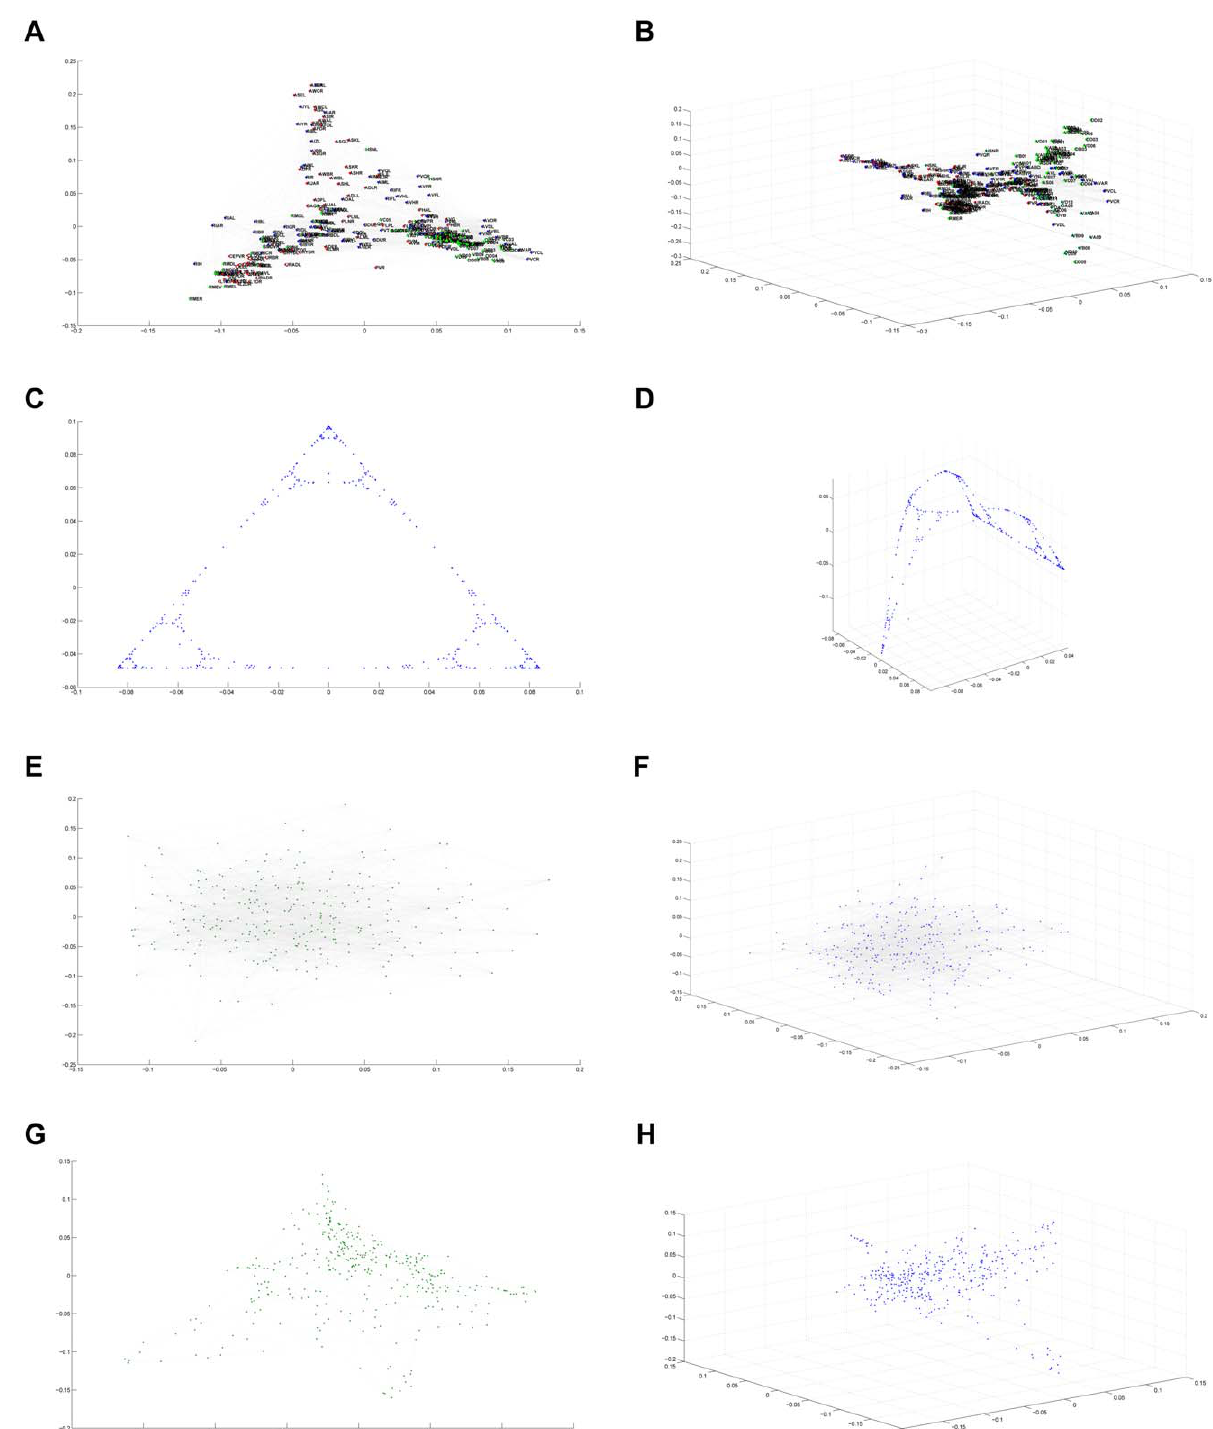
Figure 3. The Eigen Projection Method (a) C. elegans neural network, ( Q 2 , Q 3 ) (b) C. elegans neural network, ( Q 2 , Q 3 , Q 4 ) (c) Sierpinski Gasket, Level 5, ( Q 2 , Q 3 ) (d) Sierpinski Gasket, Level 5, ( Q 2 , Q 3 , Q 4 ) (e) Random Network n ~ 279, p ~ 0 : 07 , ( Q 2 , Q 3 ) (f) Random Network n ~ 279, p ~ 0 : 07 , ( Q 2 , Q 3 , Q 4 ) (g) Sierpinski Gasket Rewiring p ~ 0 : 15 , ( Q 2 , Q 3 ) (h) Sierpinski Gasket Rewiring p ~ 0 : 15 , ( Q 2 , Q 3 , Q 4 ) .